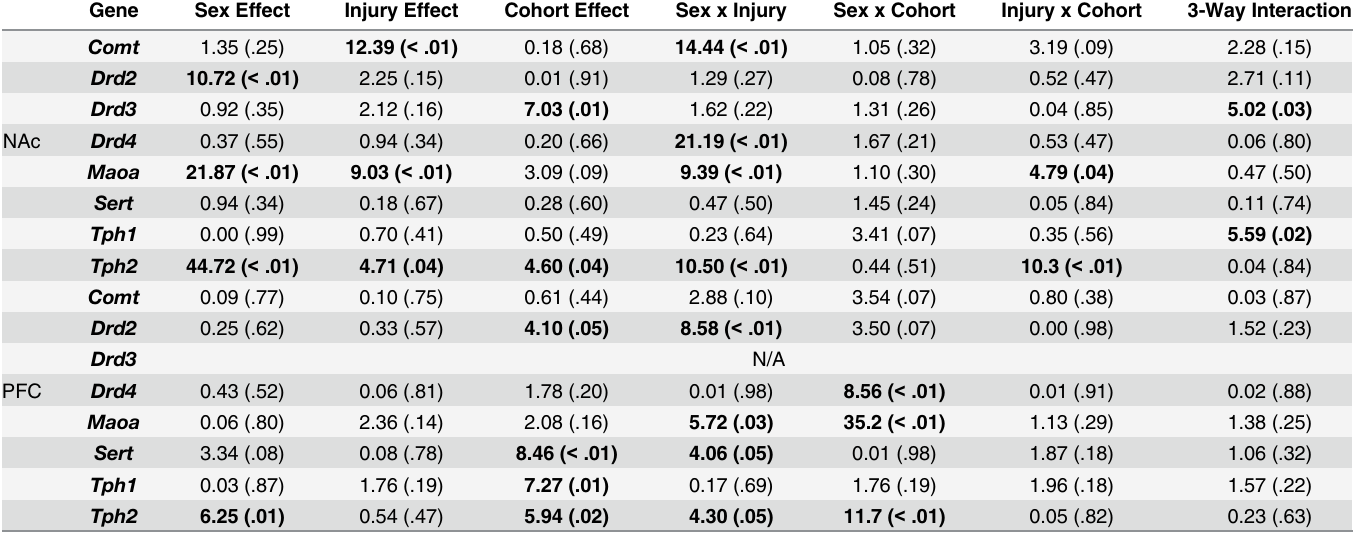
Table 3. Summary of Three-Way ANOVA results for genes examined in the nucleus accumbens and prefrontal cortex of impulsive and standard rats with and without a mTBI (F ( p ), bold text denotes significant effects). Gene Sex Effect